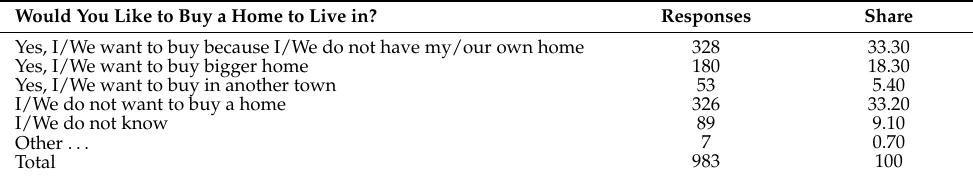
Table 4. Verified responses addressing the reasons for buying a